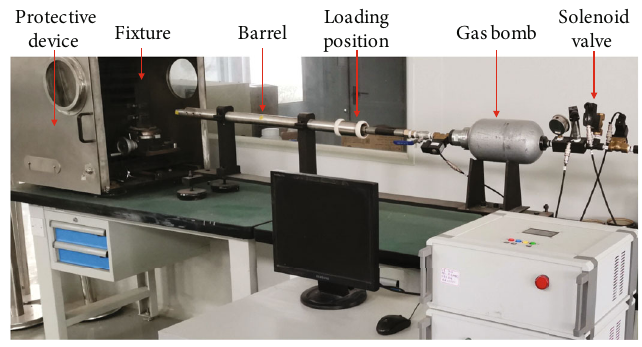
Figure 3: Gas gun device.